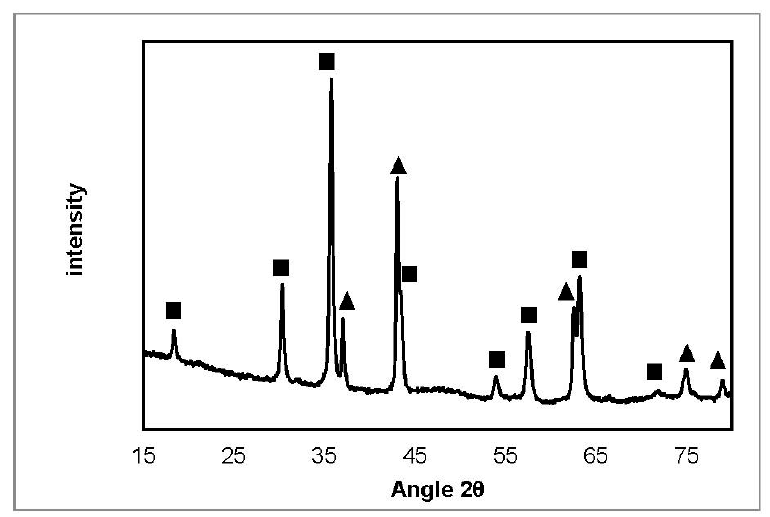
Figure 10. Micrographs of Ni-UGSO after bio-oil MemU SR at 800 °C, WHSV = 2.0 g/g cat /h and TOS = 105 h. ( A ) Zone without C deposits; ( B ) Zone with C deposits. Table 4. XRD phase legend.